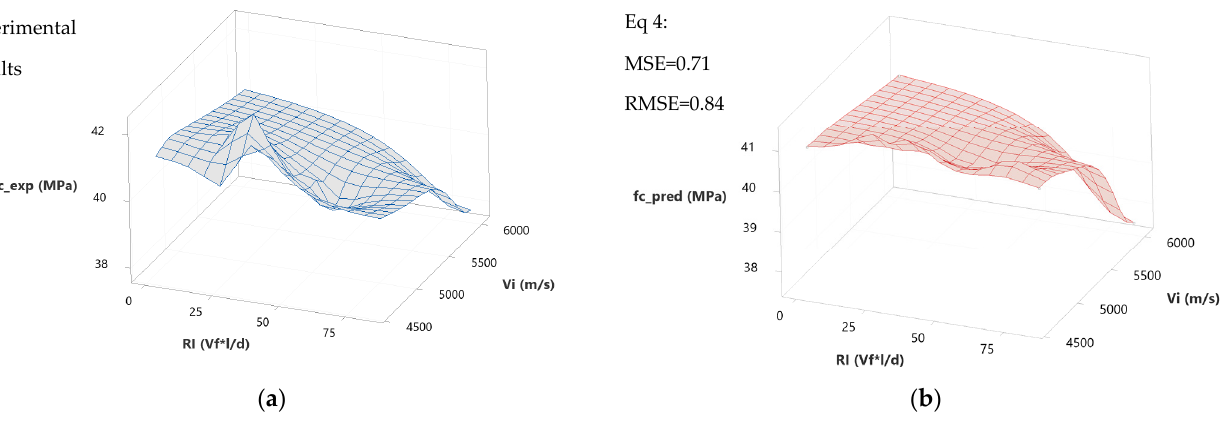
Figure 22. Three-dimensional surface of compressive strength as a function of the reinforcement index and UPV. ( a ) experimental results, and ( b ) values calculated with Equation (4). pares the experimental and calculated values with Equation (16). Table 7. Static modulus of elasticity prediction equations based on UPV.